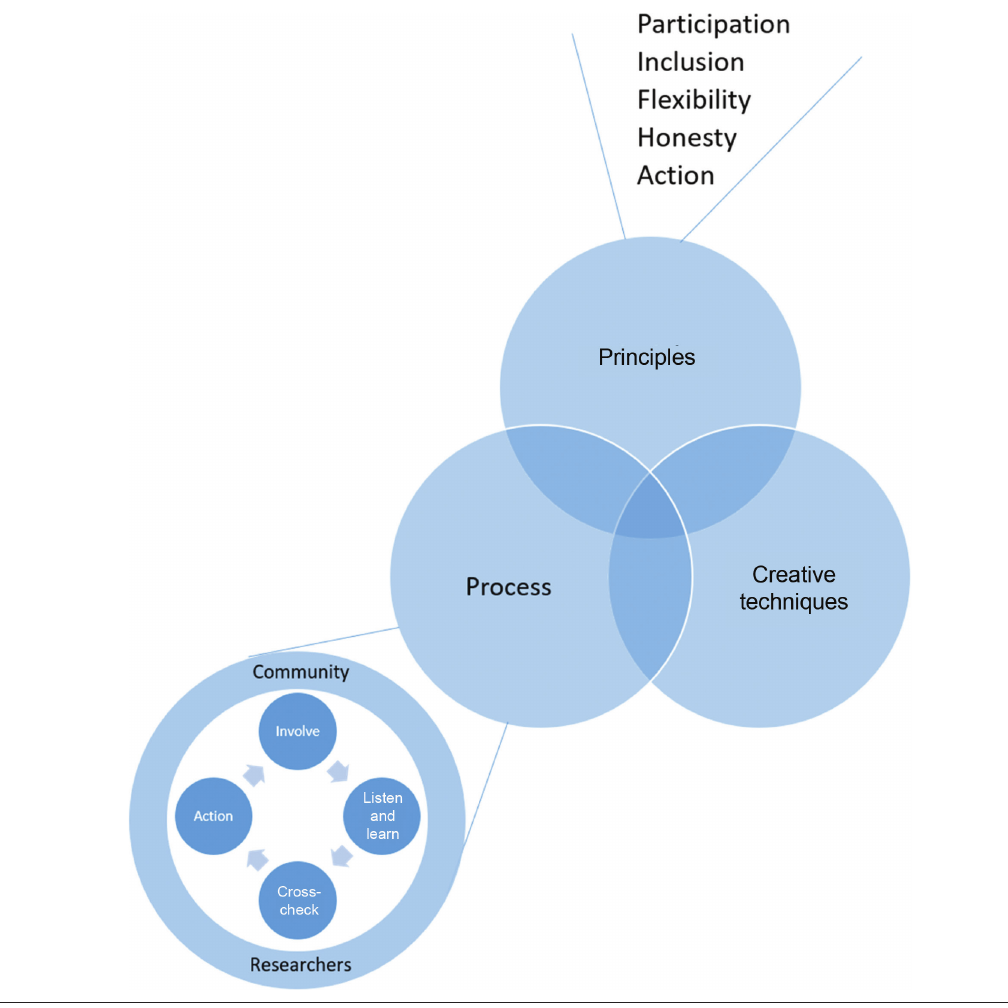
Figure 1. The Get Talking model (Source: